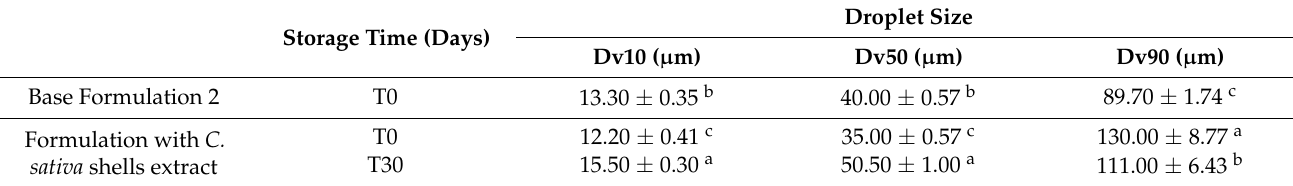
Table 5. Evaluation of droplet sizes of Base Formulation 2 and O/W cream containing C. sativa shells extract at time 0 and after 30 days of storage (mean ± standard deviation, n =